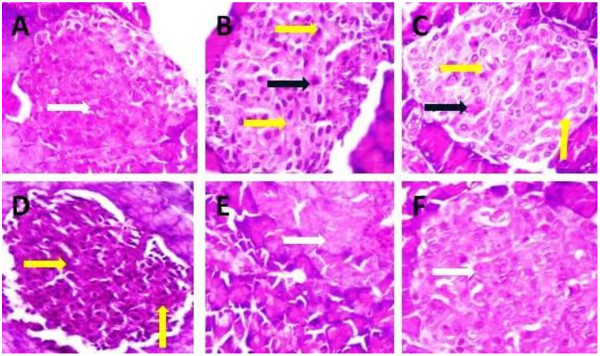
Effect of Umbelliferone β-D-galactopyranoside (UFG) photomicrographs of histological changes in rat pancreas: (A) Normal control: normal histological structure of rat pancreas showing normal islet (white arrow) (B) Diabetic control: Histopathology of diabetic control rat showing focal necrosis (yellow arrow) (C) UFG I (10 mg/kg): Histopathology of tested drug rat showing bigger size of islet and focal necrosis (yellow arrow) (D) UFG II (20 mg/kg): Histopathology of tested drug rat showing focal necrosis (yellow arrow) (E) UFG III (40 mg/kg): Histopathology of tested drug rat showing normal size of islet (white arrow) (F) Glibenclamide (10 mg/kg): glibenclamide treated rat pancreas showing normal islet (white arrow). For each group 6 rats were examined and 80 pictures were taken. The above picture for each group was chosen randomly from the 80 pictures in this group. Original magnification, 40 × .